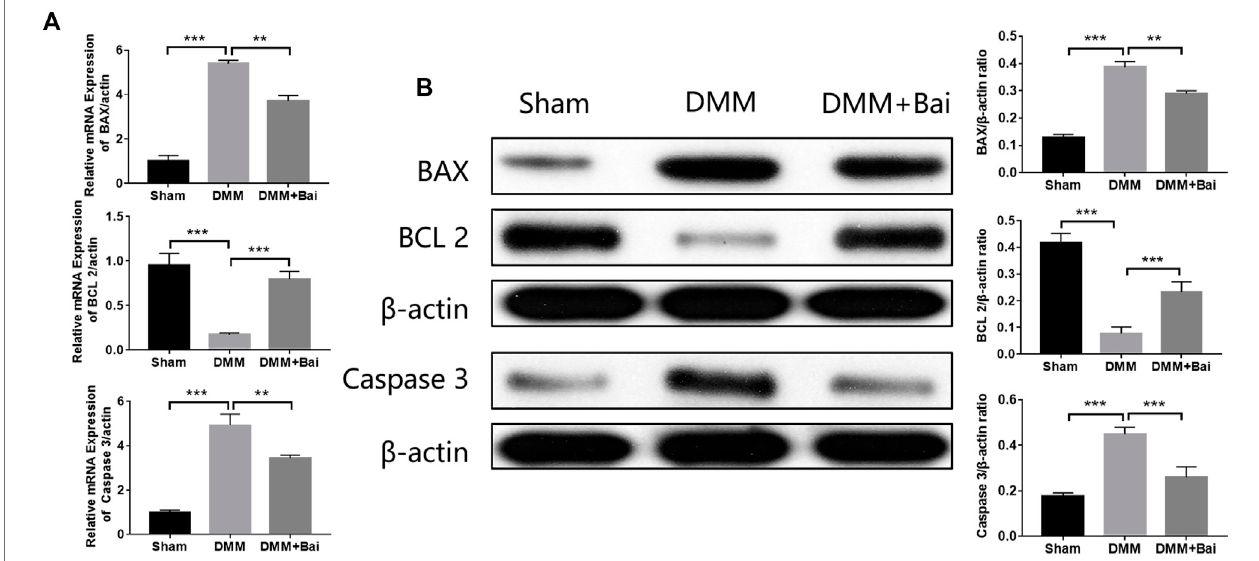
FIGURE6| Baiattenuates themRNAandprotein levelsofBAX,BCL2,and Caspase 3. (A) mRNAlevelsofBAX,BCL2,and Caspase 3. (B) Proteinlevels ofBAX, BCL 2, and Caspase 3 were measured by Western blotting. Data are shown as the mean ± SD. ** p < 0.01, *** p < 0.001 vs. the DMM group.